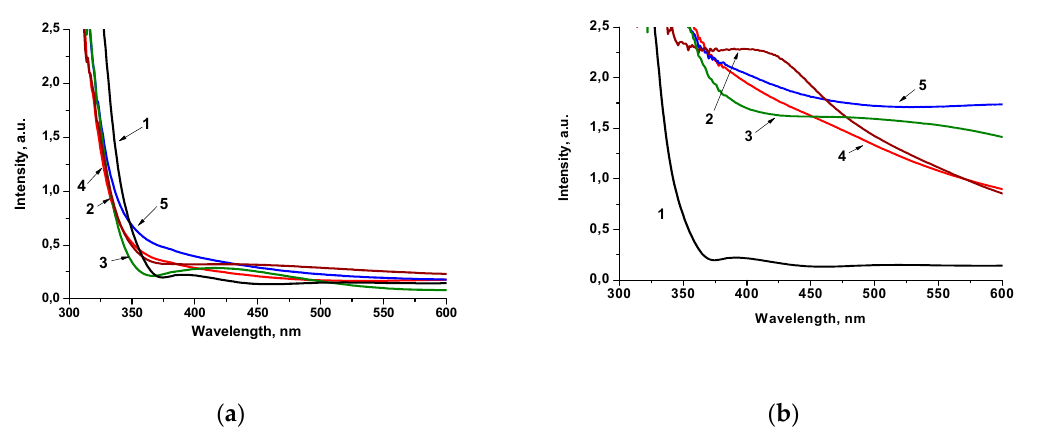
Figure 2. Absorption spectra of 1 mol.% Pt-doped films prepared by Method 1 ( a ) and Method 2 ( b ): (1) TiO 2 ; (2) Pt-TiO 2 ; (3) Pt-TiO 2UV ; (4) Pt,N-TiO 2 ; (5) Pt,N-TiO 2UV .